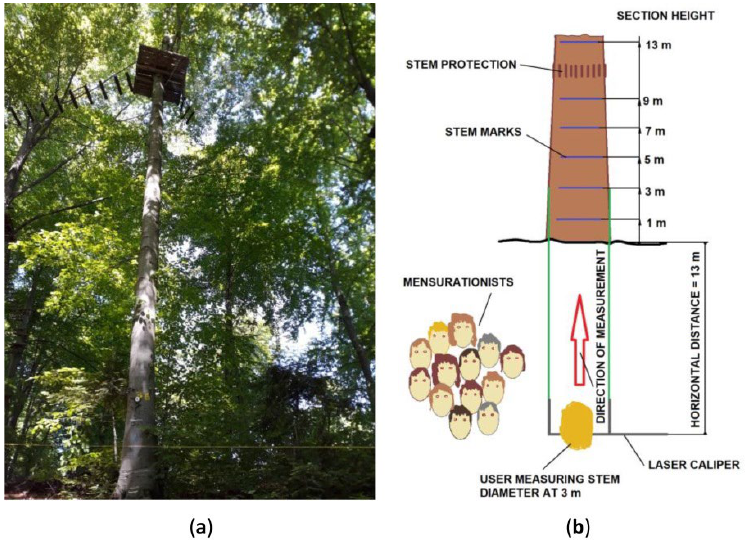
Figure 1. Studied tree ( a ) and sketch of field data collection ( b